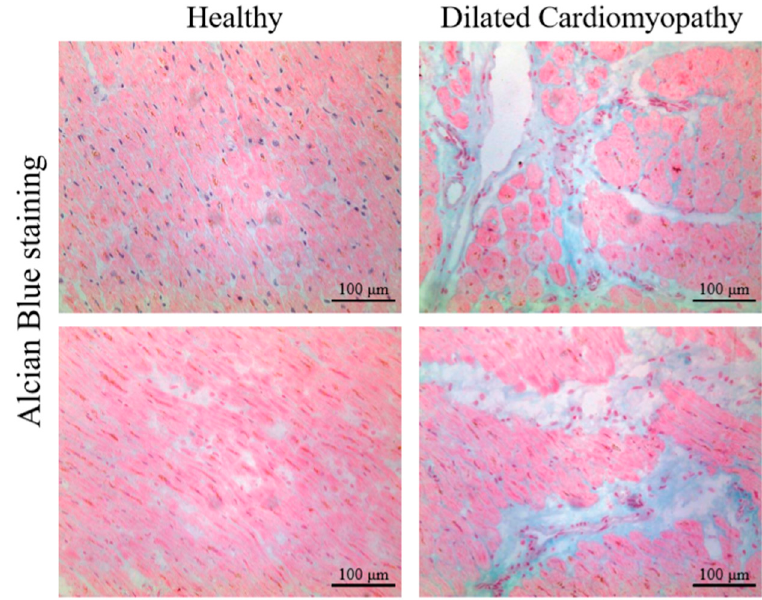
Figure 1. Alcian blue staining showing areas of glycosaminoglycan (GAG) accumulation in hearts from patients with dilated cardiomyopathy (DCM) compared to healthy (non-failing control, NFC) hearts.